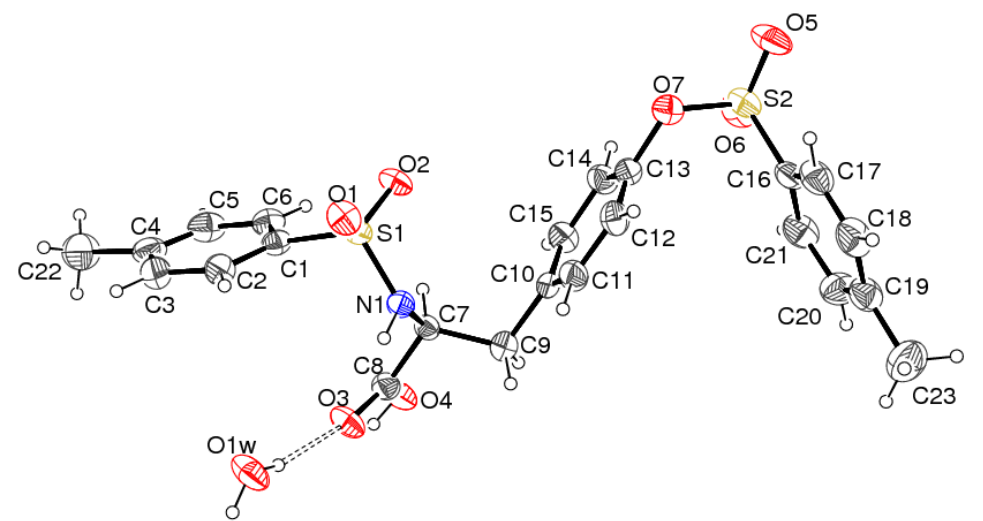
Figure 4. The molecular structure of 2 ·H H  O hydrogen bond is indicated by a double-dashed